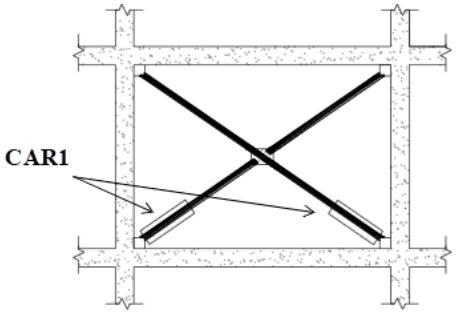
Figure 5. Installation of two CAR1 dampers in X-shaped steel diagonal braces.